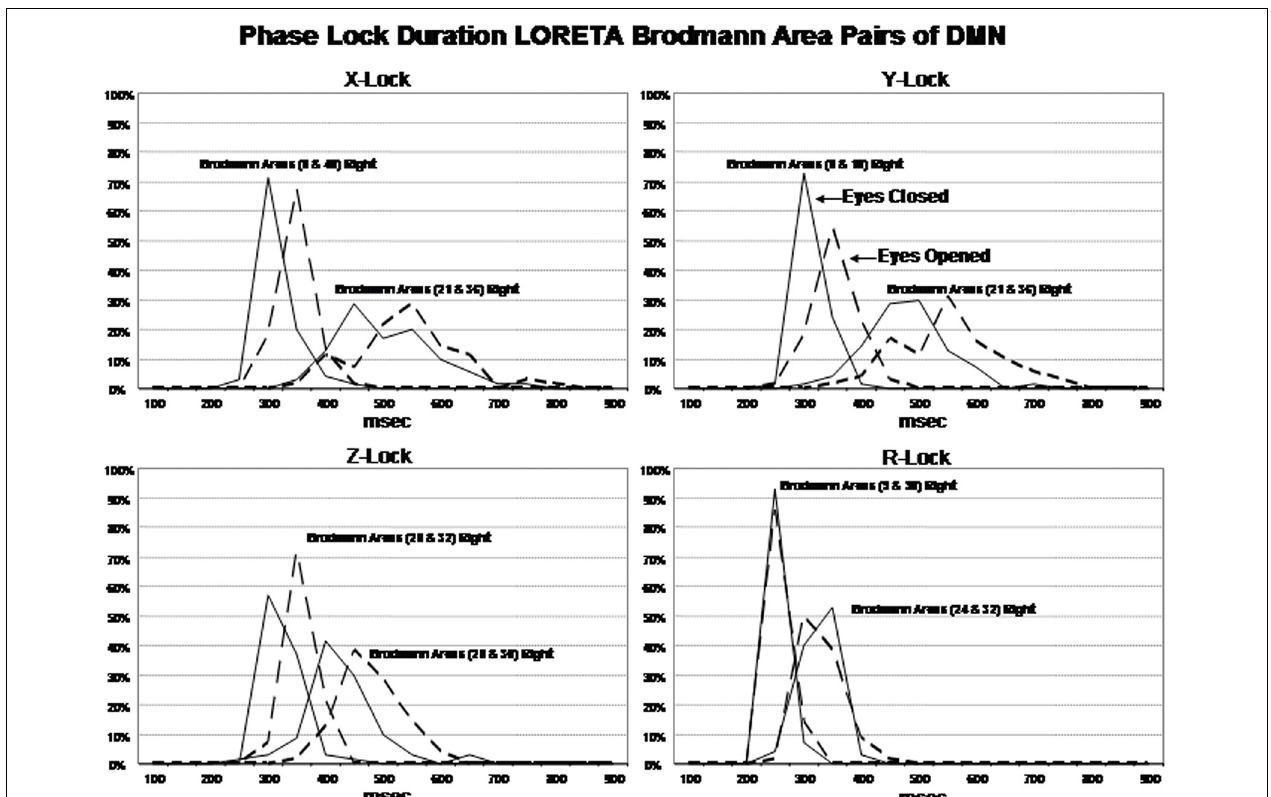
FIGURE 4 | Phase lock durations between Brodmann areas in the x, y, z LORETA time series directions and the resultant vector in the lower right (cid:2) x 2 + y + z 2 . The x-axis is phase lock duration in milliseconds and where R = the y-axis is the percent of subjects that exhibited a given phase lock duration for different Brodmann area pairs. The solid line is the eyes closed condition and the dashed line is the eyes open condition. All of the subjects are